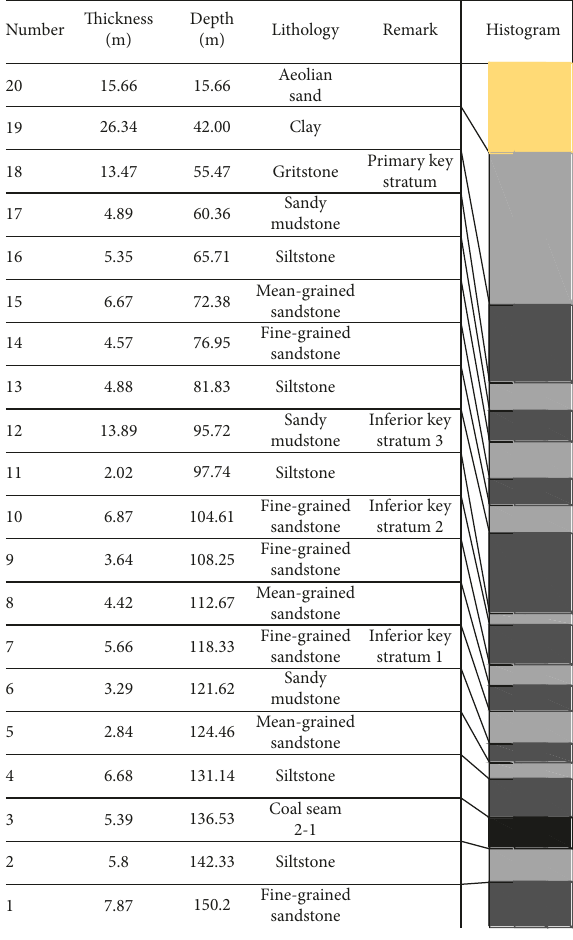
Figure 1: Drilling columnar diagram and position of key strata.